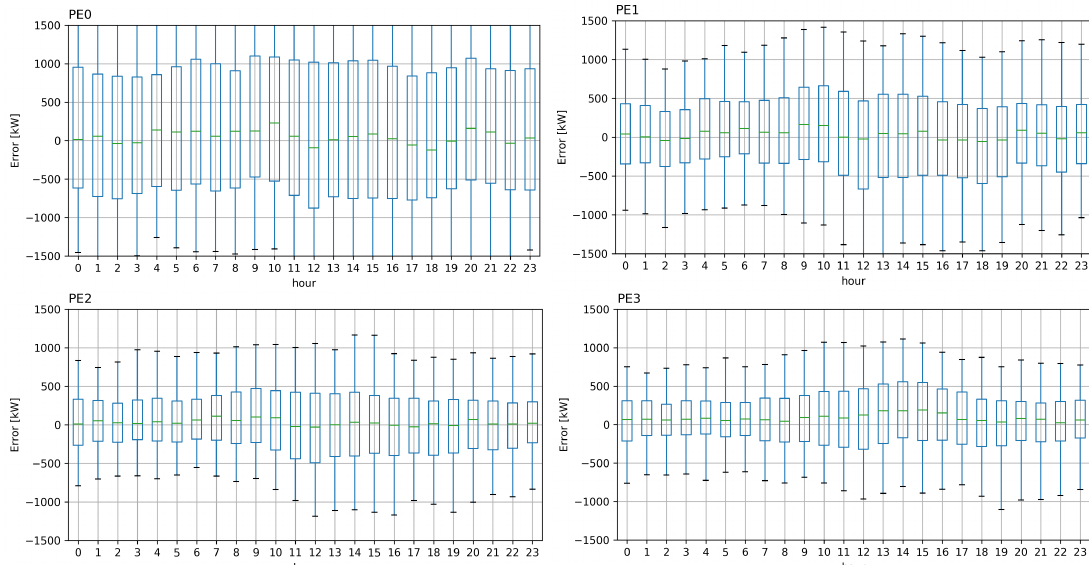
Figure 6. Boxplot of the PE forecast error as a function of the hour of the day. The box represents the interquartile range, the line in the box is the median, and the whiskers are set at the 5 and 95 percentile of the data range. The improvement in the forecast accuracy is evident. The uncertainty is still related to the PV generation, but the pattern is less apparent compared to the net load forecasting case, due to the influence of the wind power forecast